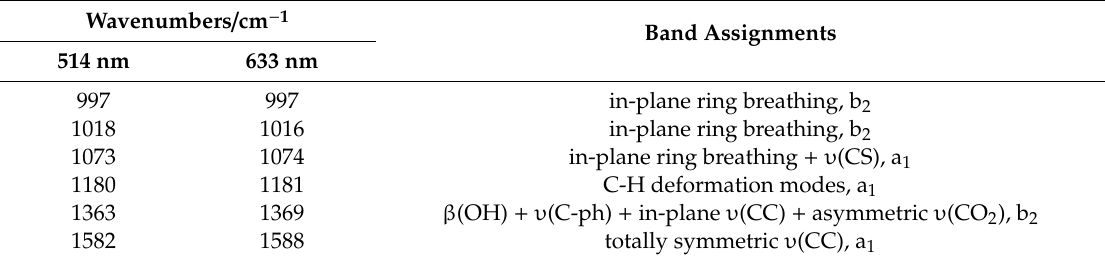
Figure 3. Surface-enhanced Raman scattering (SERS) spectra of the Ag/ZnO/MBA systems under ( a ) 514 nm and ( b ) 633 nm laser excitations. The ZnO sputtering power in the Ag/ZnO systems was 100 W, and the Ag sputtering power was 10, 20, 30, and 40 W. The sputtering powers for the pure ZnO and Ag films were 100 and 40 W. Table 1. Wavenumbers and assignments of the SERS bands of MBA based on 514 and 633 nm laser excitations a .